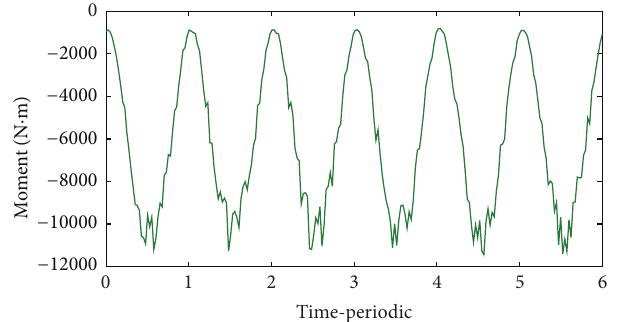
Figure 8: The input moment of the